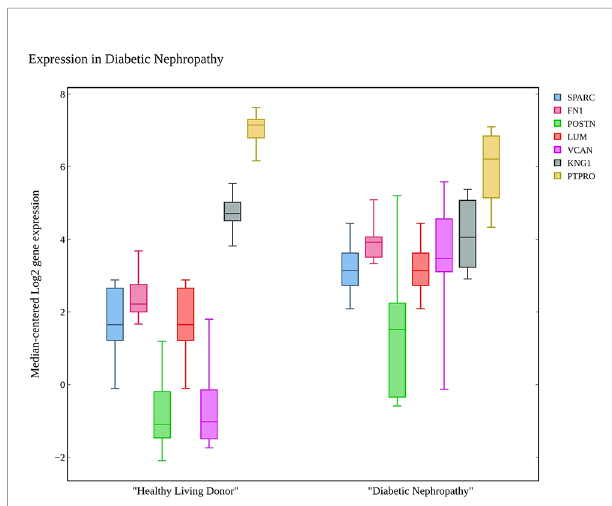
FIGURE 6 | The box plot of seven candidate genes that exhibit the over and under expression rates in diabetic nephropathy in comparison with healthy living